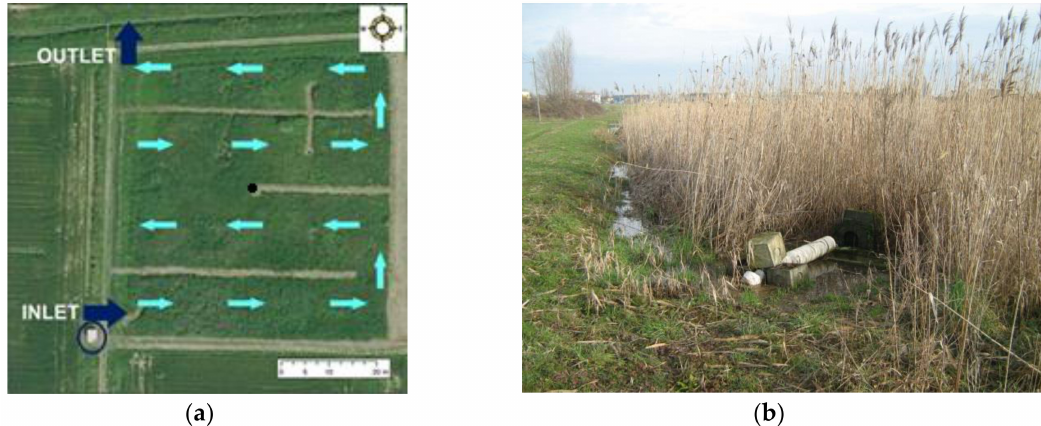
Figure 1. ( a ) Surface flow constructed wetlands (SFCW) scheme. The pump of the wetland is located on the south-western corner (dark blue circle). Dark blue arrows represent the inlet and the outlet. The three banks inside the basin force water to follow the path indicated by the light blue arrows. The black dot in the middle indicates the position of the phreatimeter ( b ) photo of the SFCW at the inlet (south-western corner) during